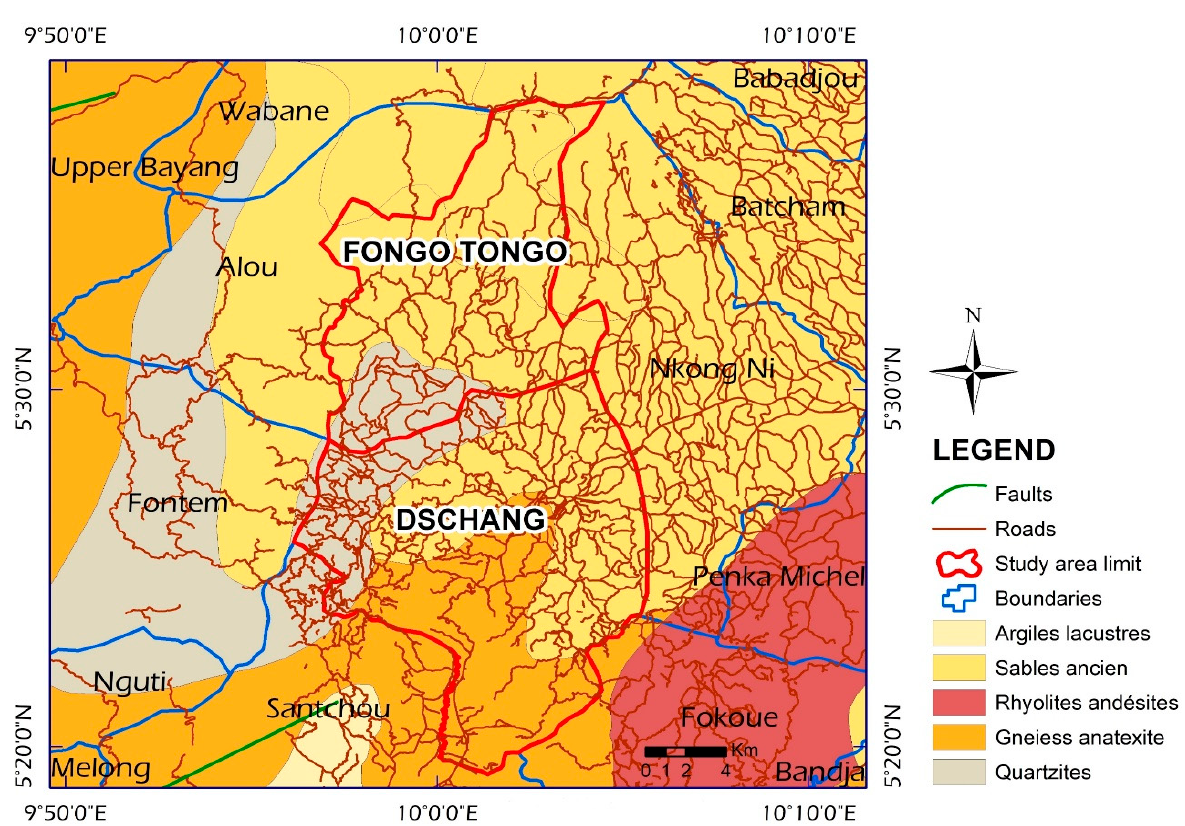
Figure 1. Soil characteristics map of the area.